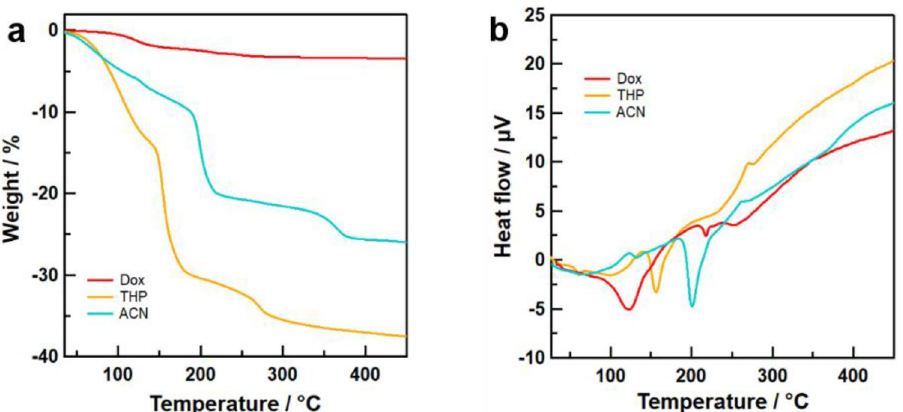
Figure 4. ( a ) TGA curves and ( b ) DTA curves of 70Li 2 S–30P 2 S 5 precursors synthesized using Dox, THP, and ACN as